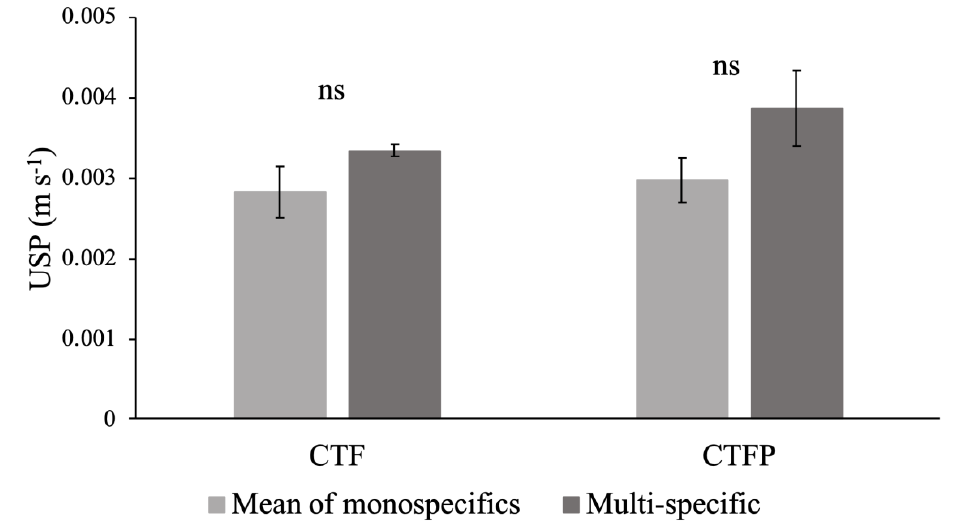
Figure 4. Differences between the mean of the monospecific and the multi-specific conditions at the discharge 2 L s −1 m −1 . The bars represent the mean ± standard error. Significance level: ns = not